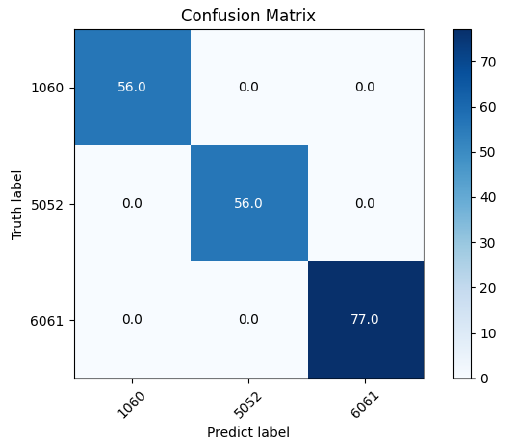
Figure 20. Confusion matrix results for the RGB dataset.